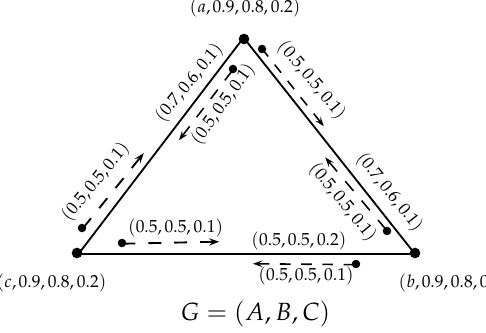
Figure 7. Single-valued neutrosophic incidence